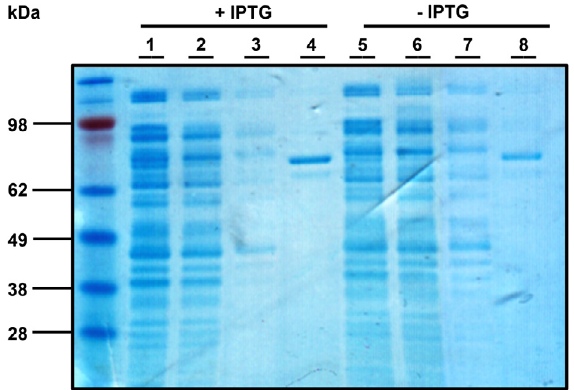
Figure 2. Purification of GST-PP5 from BL-21 cells. Cells were grown to OD = 0.5 and IPTG-induced (0.1 mM) (lanes 1–4) and uninduced (lanes 5–8) cultures were left to stir for two hours at room temperature. Protein was extracted and purified using GST-spin columns. Lanes are representative of the elution process: total protein lysate (lanes 1 and 5), flow through washes (lanes 2–3 and 6–7) and GST-PP5 protein eluate (lanes 4 and 8).